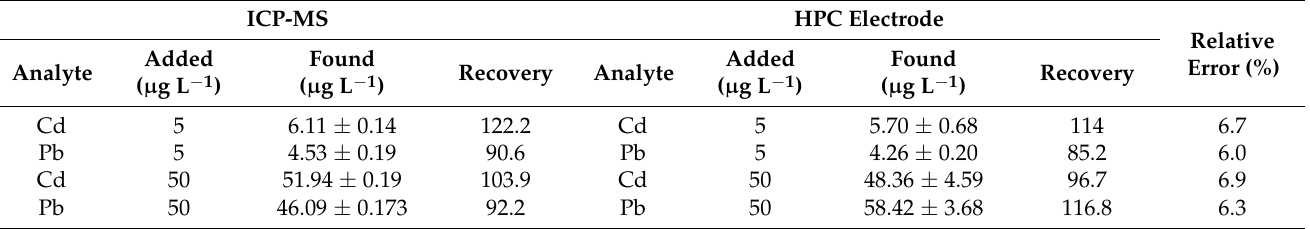
Table 1. Cd and Pb concentrations in tap-water samples spiked with standard heavy metal solutions measured, using ICP-MS and HPC electrodes.